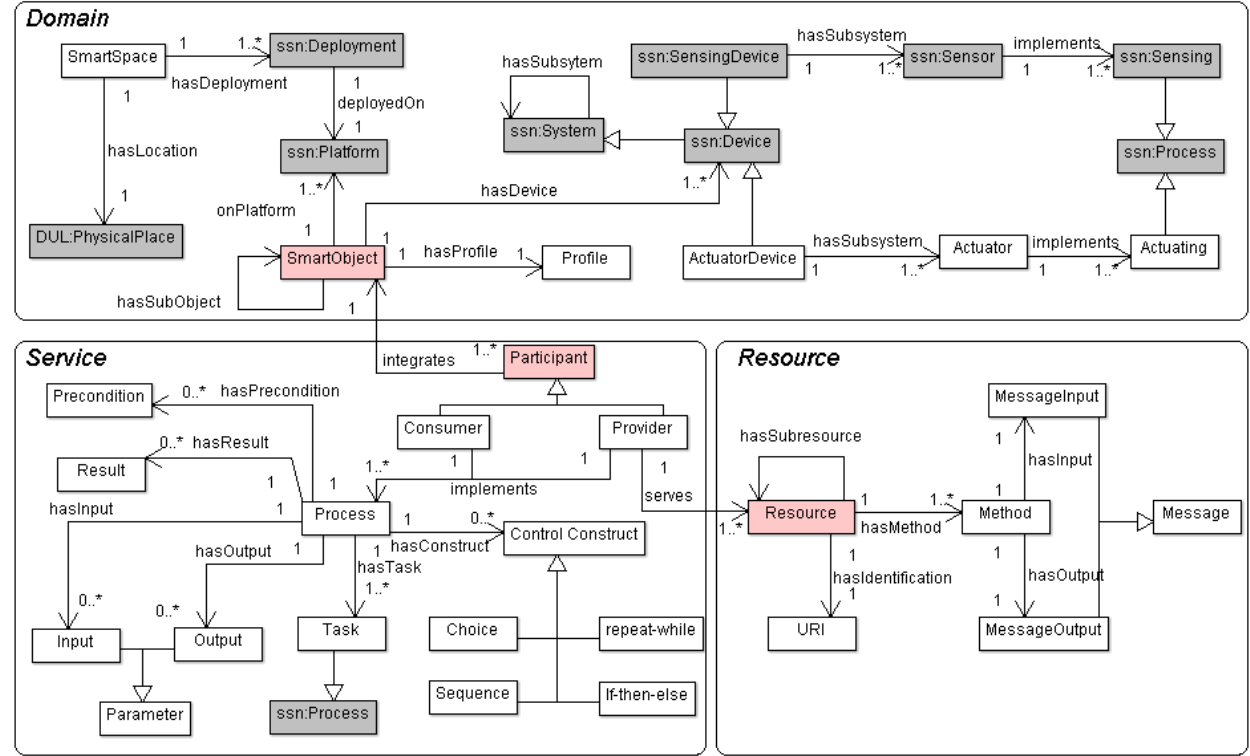
Figure 7. Overview of the Smart Space Ontology: modules, classes and relations. In grey color, classes coming from SSN